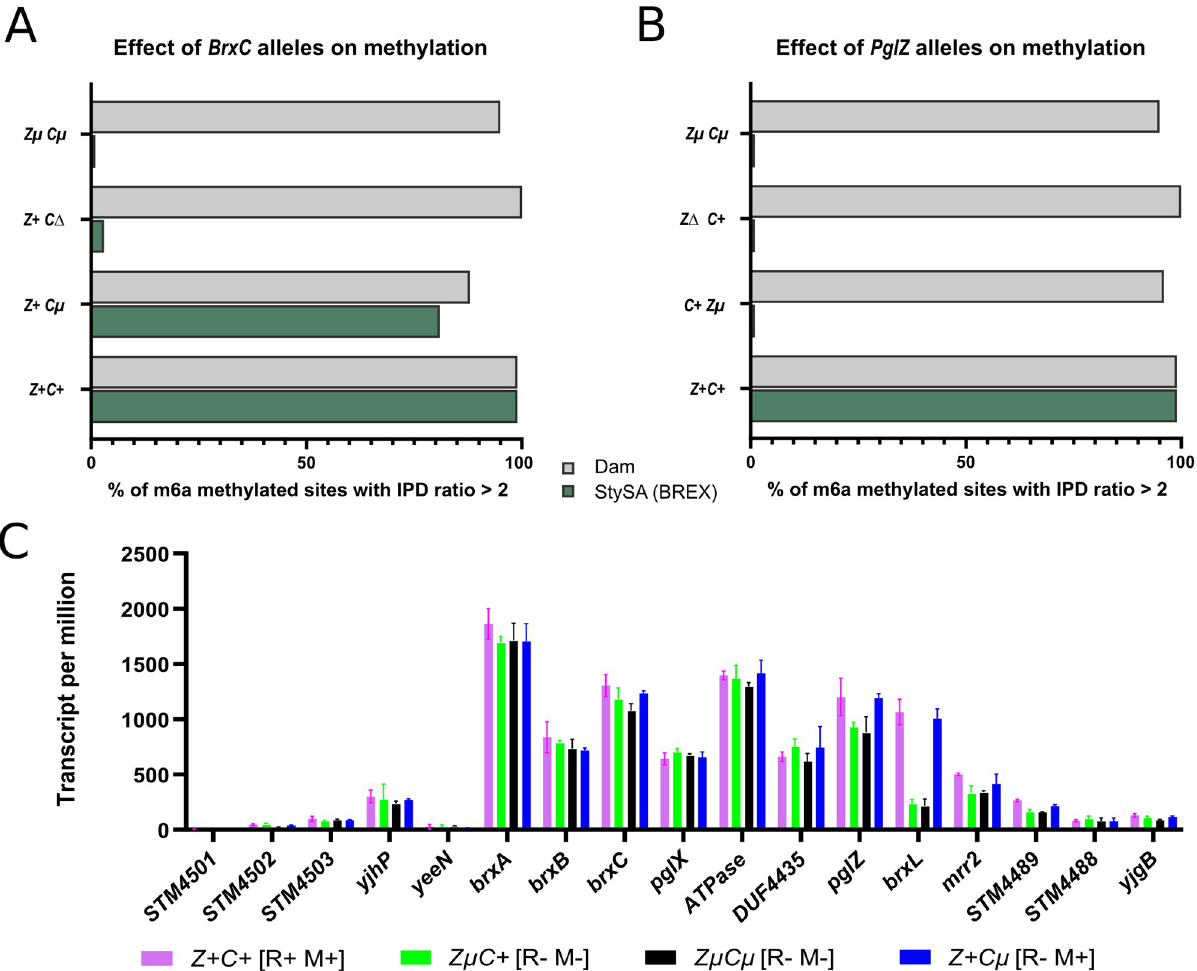
Fig 3. BrxC and PglZ alleles determine R and M phenotypes and BrxL transcript abundance. Panels A and B: effects of brxC (Panel A; strains A, D, B, J of Table 1) and pglZ (Panel B, strains A, E, C and J of Table 1) alleles on methylation of StySA sites (GATC A G green bars), with Dam sites (G A TC; gray bars) serving as a control. X-axis: fraction of sites methylated measured by delay of incorporation time (IPD) opposite A in the site relative to unmodified A. Y axis: genotype. Panel C: Transcription level across CDSs in the StySA neighborhood for four strains (J, C, A, B) with clustered mutations ( μ ) or WT (+) in brxC and pglZ . Strain restriction phenotypes are R + : 100-fold reduction in plaque formation with phage L; R - no restriction activity. Vertical axis is transcripts assigned per million transcripts sequenced and is intrinsically normalized to feature size [101]. pglZμ is polar on brxL